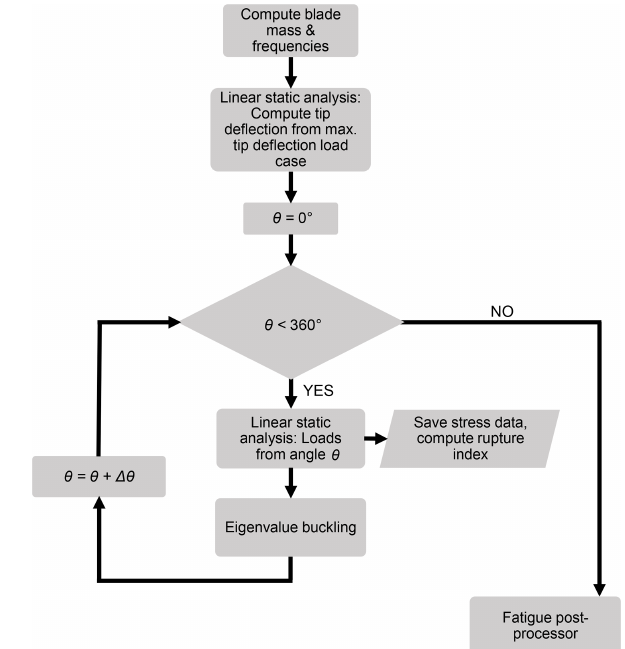
Figure 5. FE operations’ workflow in a single iteration of the opti- mization.